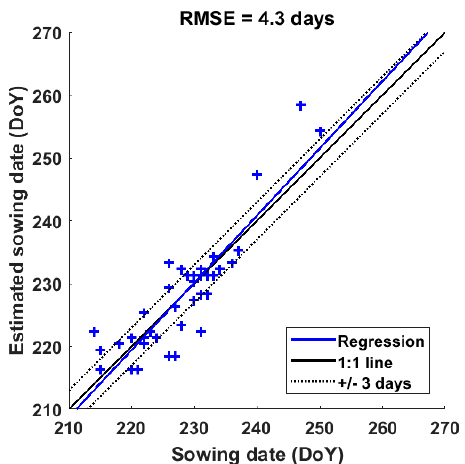
Figure 15. Retrieved sowing date in Autumn-Winter crop by CKS vs. ground data collection of 30 rice fields in Chau Thanh and Thoai Son districts, An Giang Province. Blue line represents the linear regression between two datasets.